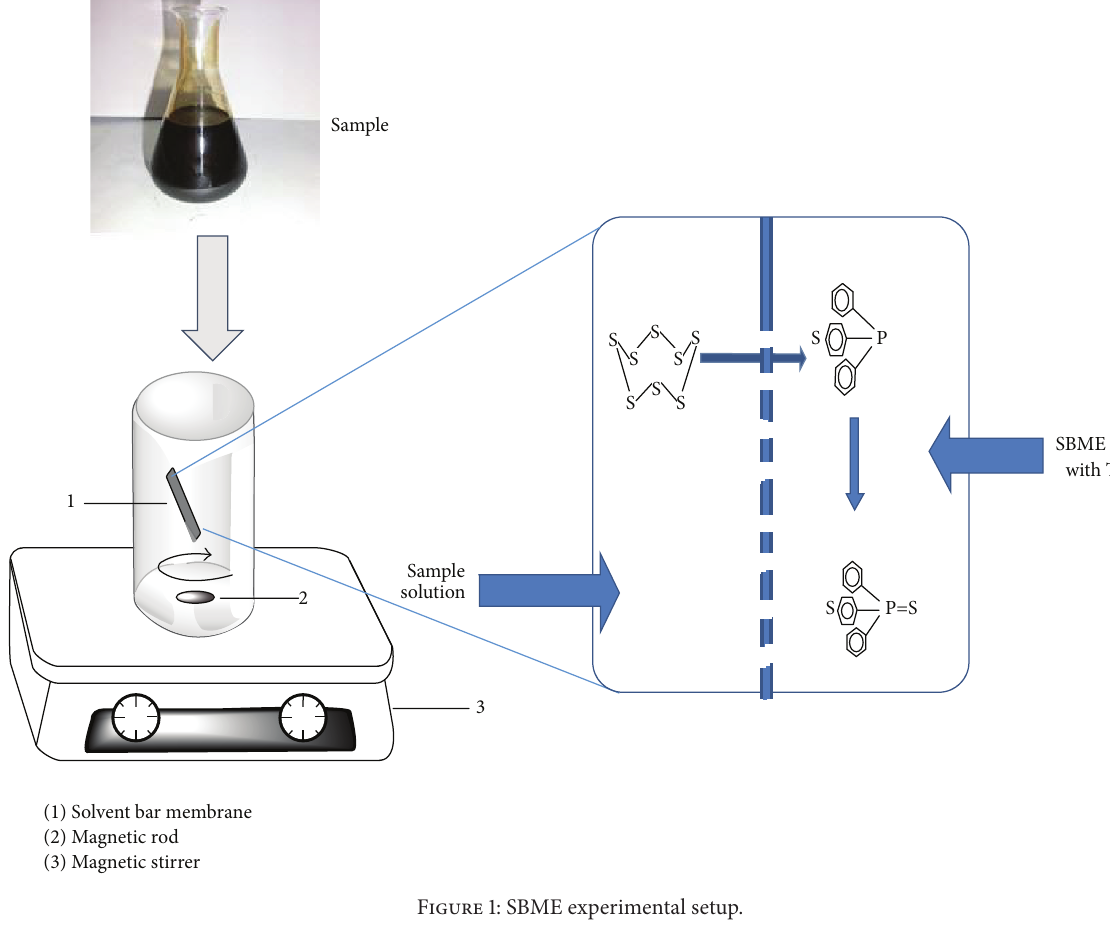
Figure 1: SBME experimental setup.